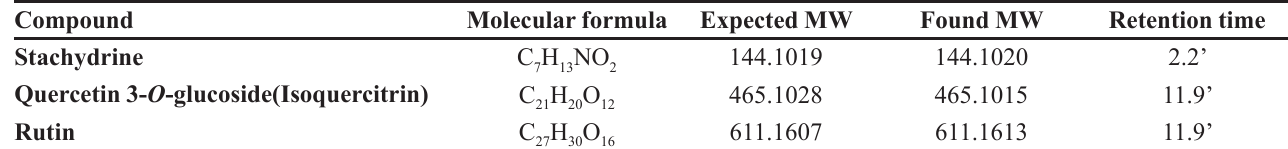
TABLE III - List of compounds determined by using IT-TOF Compound Molecular